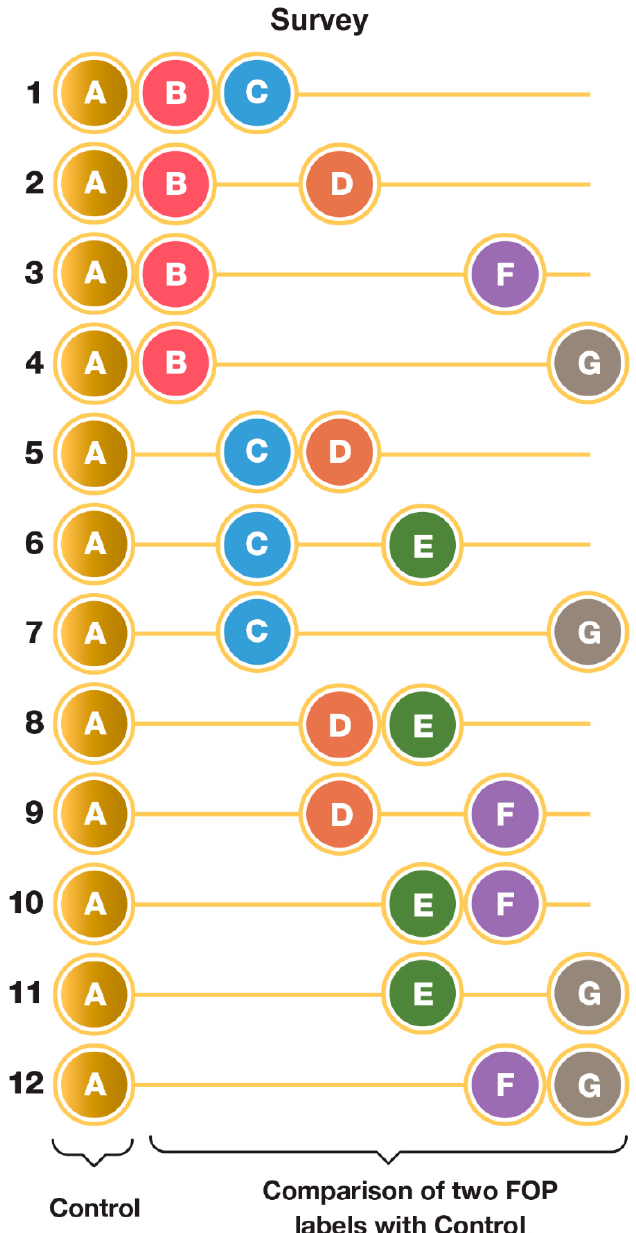
Figure 3. Design of the twelve surveys, with each including the ‘no-label’ control and a different combination of two FOP labels. Graphical details of symbols A to G as depicted in Figure 2.